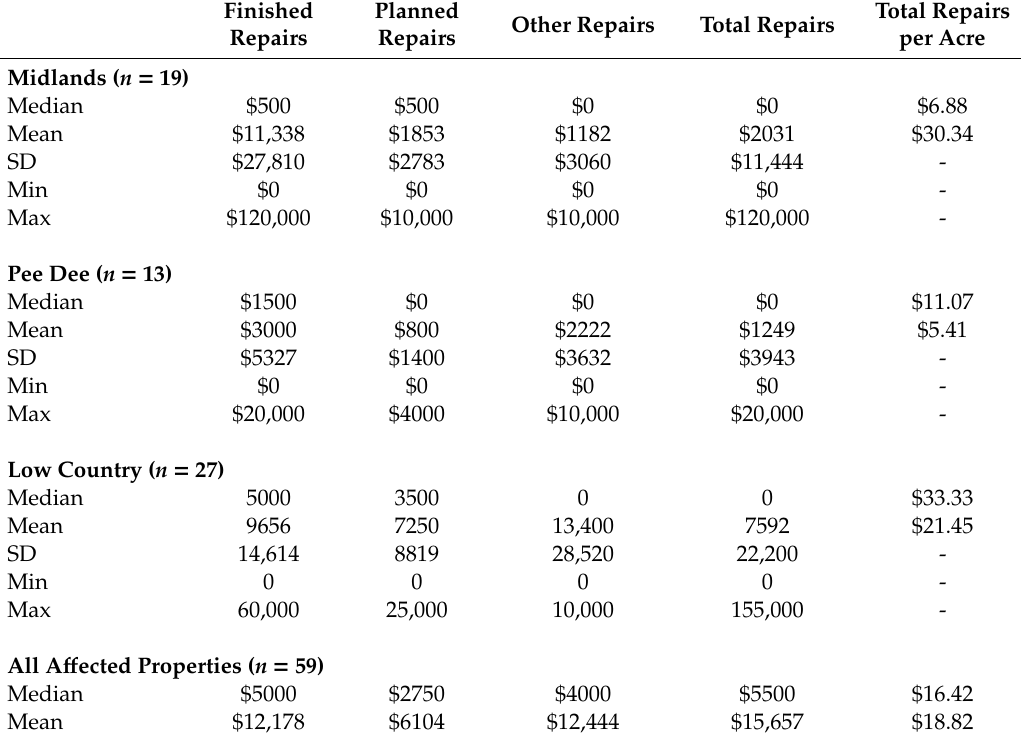
Table 2. Costs of repairs by region on the property that sustained the most damage from the 2015 flood (June–August 2017 data collection). All values are in